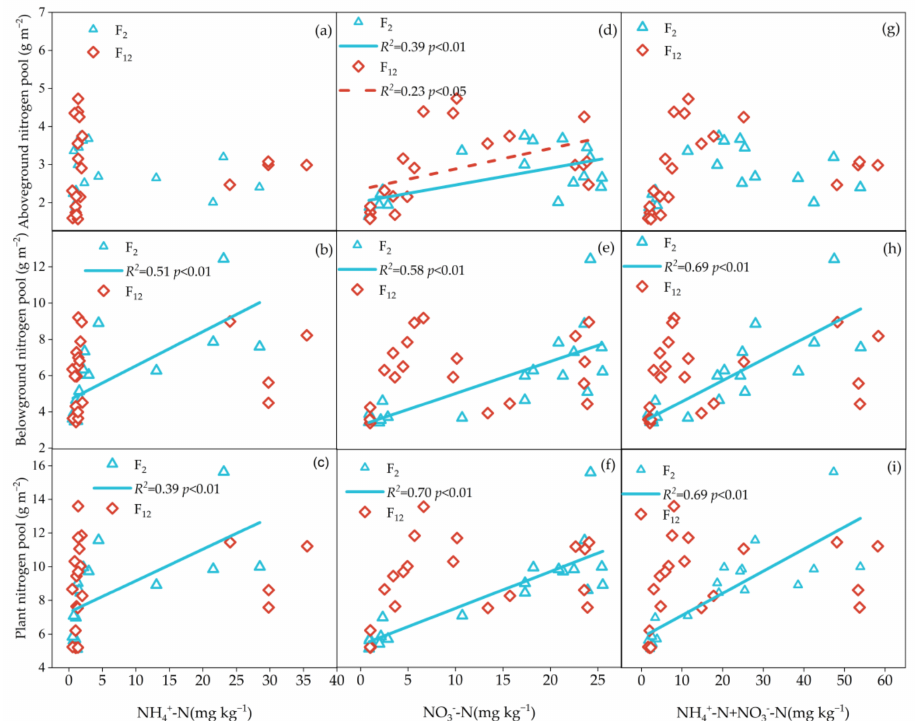
Figure 5. The relationships between PAGN, PBGN, PN and soil NH 4+ -N concentration ( a – c ), soil NO 3 − -N concentration ( d – f ) and soil NH 4+ -N +NO 3 − -N concentration ( g – i ). Blue triangles with solid lines indicate 2 N additions yr − 1 (F 2 ). The red quadrilateral and dotted line indicate once a month (F 12 ).